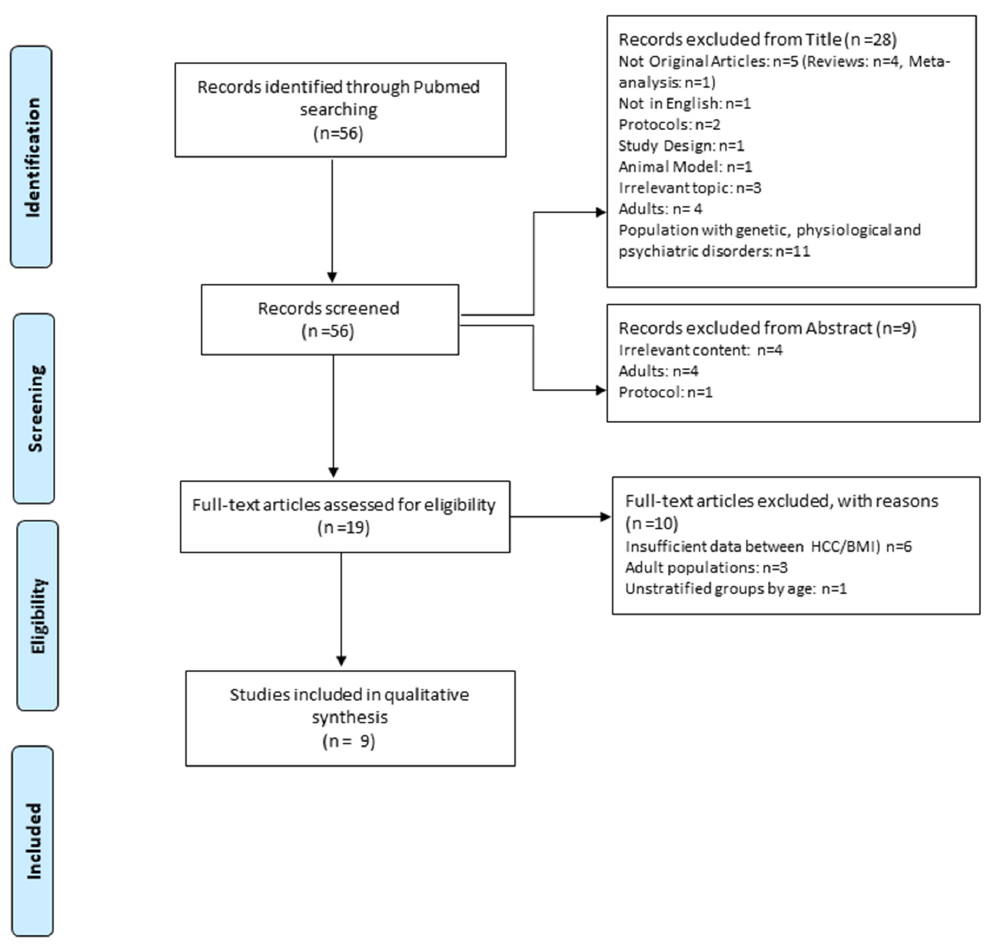
Figure 1. Flow diagram of the study selection.